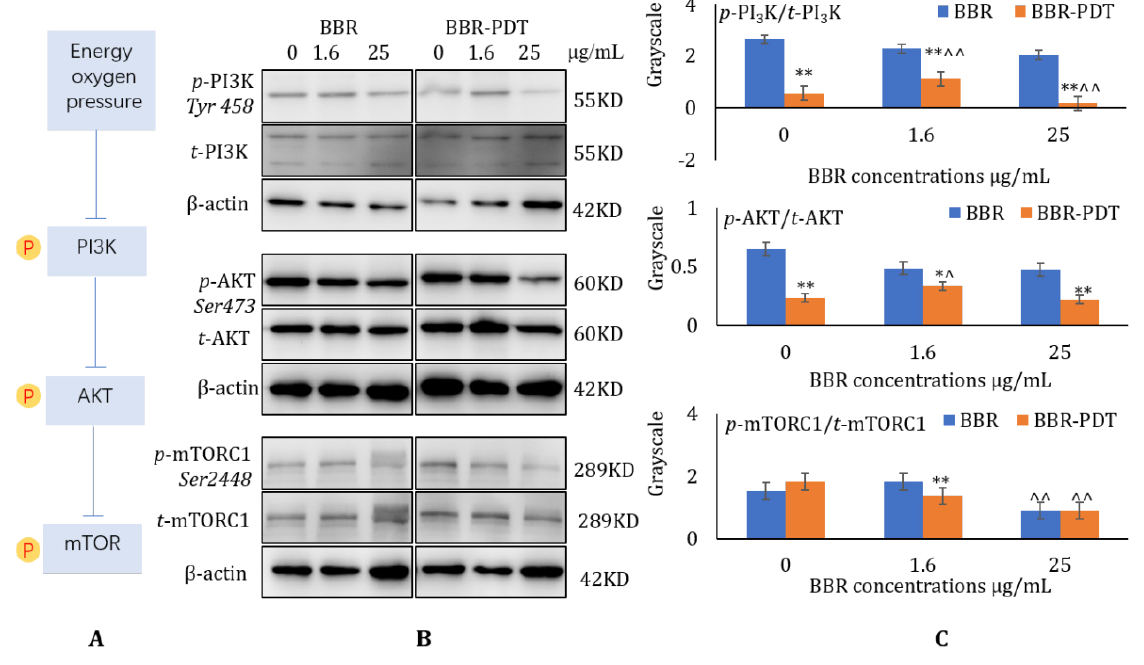
K-AKT-mTOR signaling pathway. 3